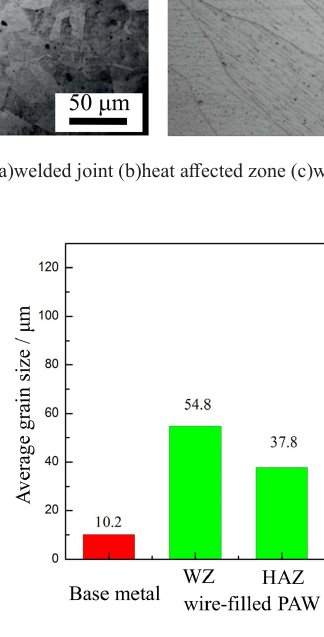
Figure 7. Grain Size in different zones of